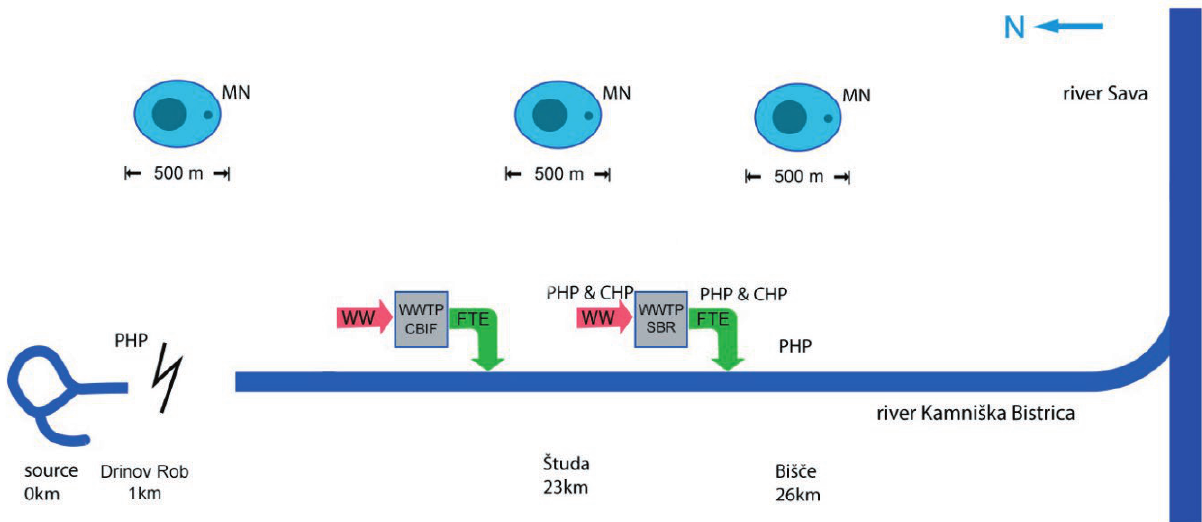
Figure 1. Study map of models WWTP including Allium M test and Pisces MN test. Samples and fishes were taken from river Kamniška Bistrica. Legends: CBIF: cart board industry factory with WWTP, WWTP: wastewater treatment plant; WW: wastewater; WWTW: waste- water treatment work; FTE: final treated effluent; PHP: physical-chemical parameter; CHP: chemical